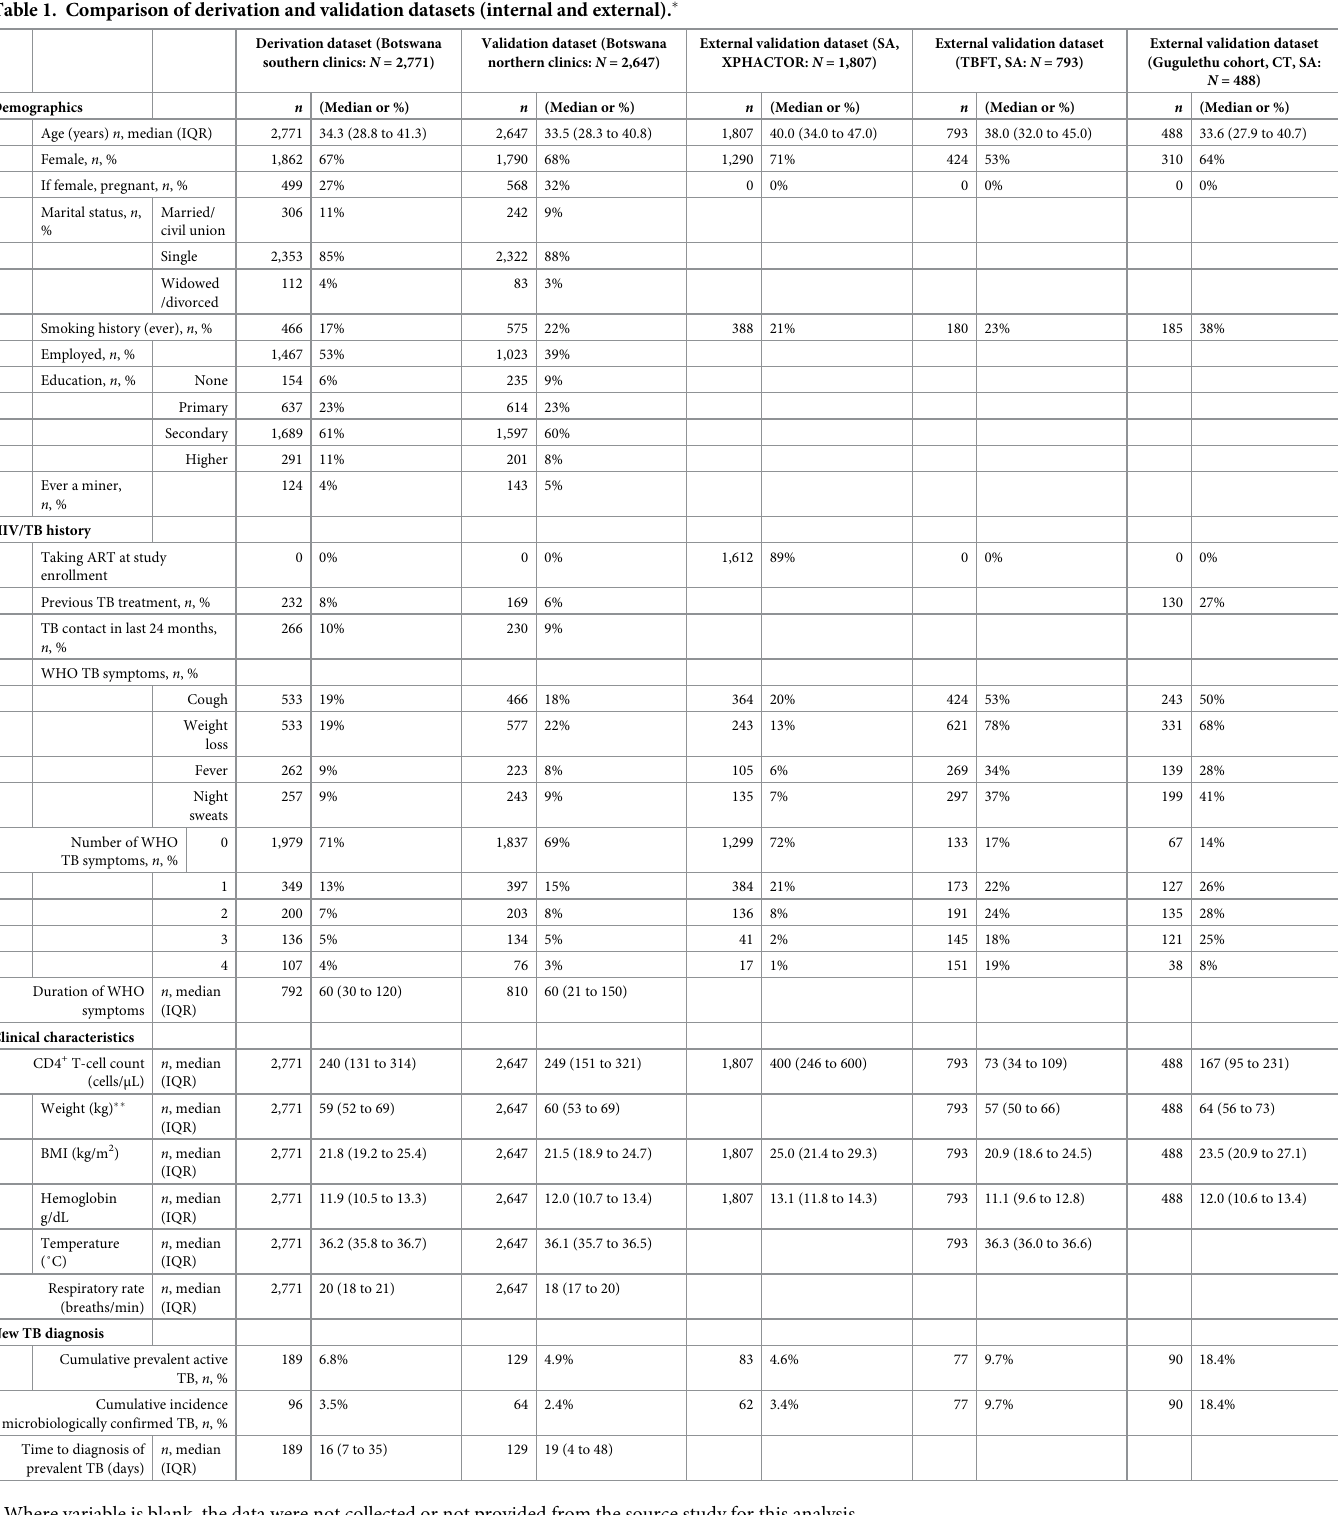
Table 1. Comparison of derivation and validation datasets (internal and external). �